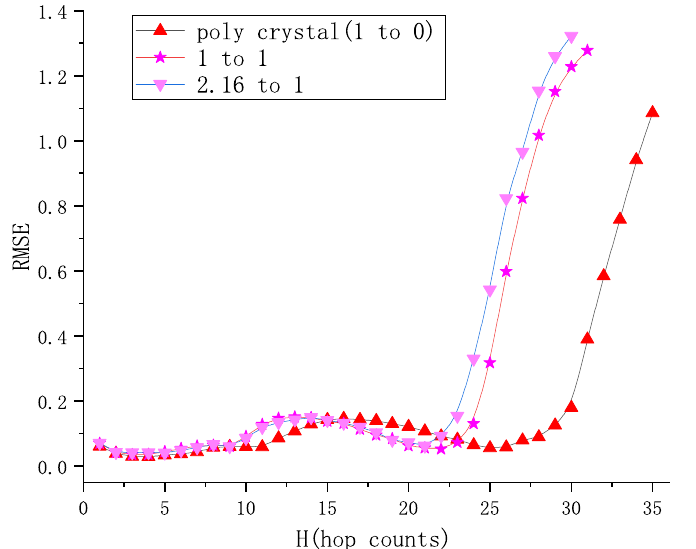
Figure 4. Root-mean-squared error (RMSE) versus hop counts (H). The number of anchor nodes in all systems is about 60% of the total number of